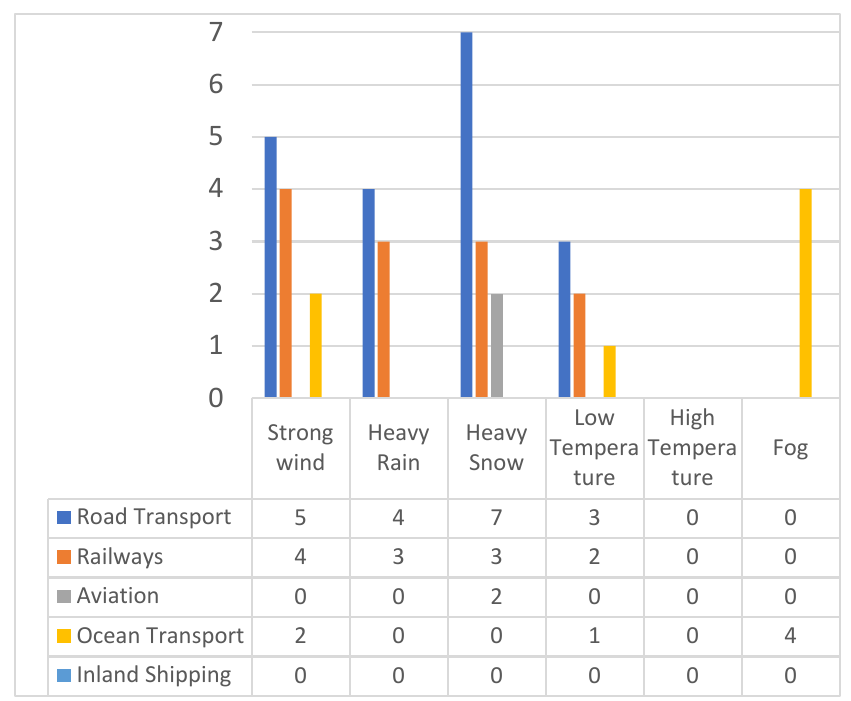
Figure 1. The number of extreme weather events impacting different transport modes in 2000–2010 in the Nordic countries [27].